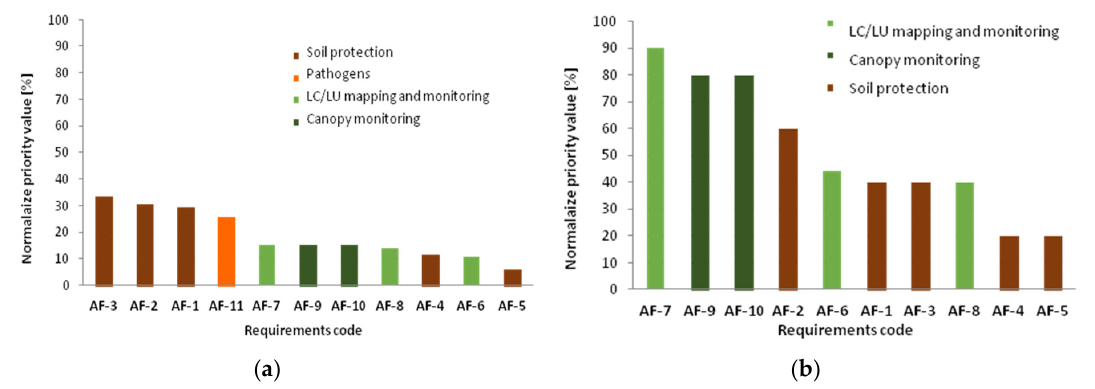
Figure 6. Ranking of the Agriculture / Food security (“AF”) requirements based on the priority values assigned by the Environmental control system community, constituted by the Italian National System for Environmental Protection (SNPA) and the Italian National Committee for Operational Hydrology Services ( a ) and CREA, the Council for Agricultural Research and Analysis of the Agricultural Economy ( b ).